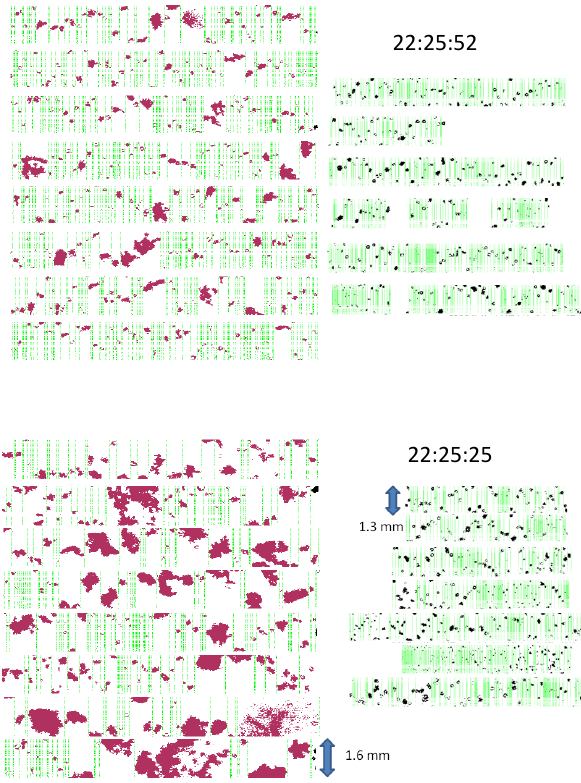
Fig. 8. 2DC (red) and 2DS (black) images taken near 22:25:52 (top) in the upper anvil and at 22:45:25 (bottom) in the lower anvil re- gions. Corresponding CPI images are shown in Fig. 7 for